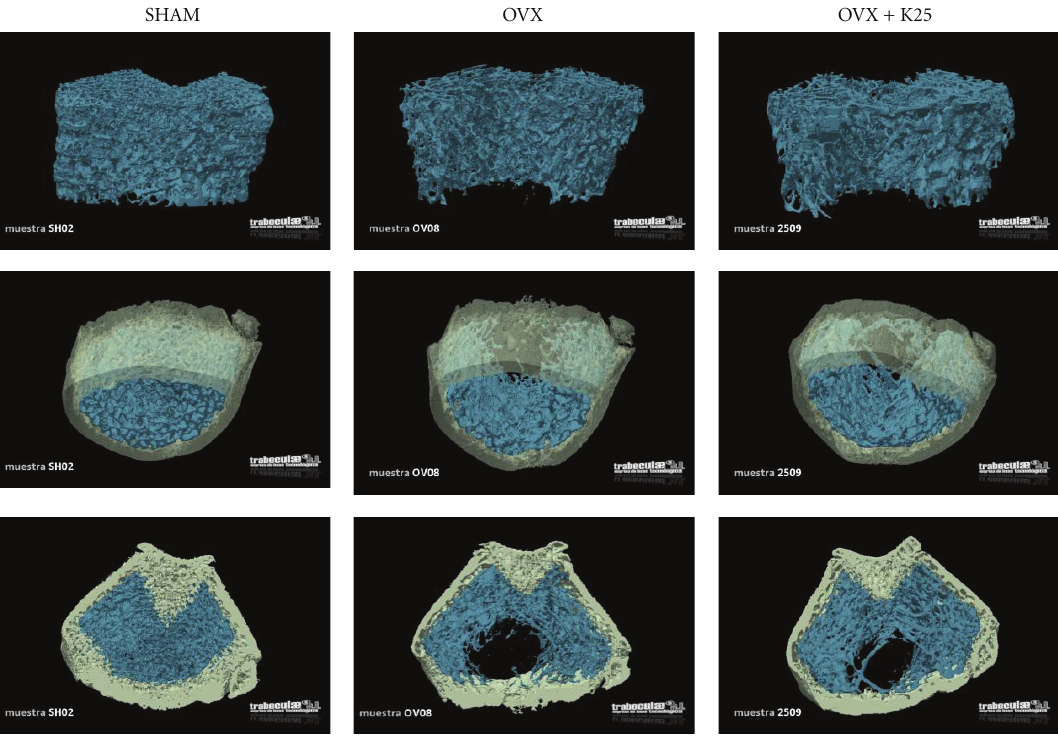
Figure 1: Representative images of bone trabecular 3D-microarchitecture in femur sections of all the study groups obtained by computed microtomography. The study groups of female Wistar rats, 6 months old at the beginning of the study, are ovariectomized (OVX) or sham- operated (SHAM) and randomized in the following groups: SHAM group (SHAM) treated with vehicle for 3 months; ovariectomized group (OVX) also treated with vehicle for 3 months; ovariectomized group treated with Kalsis at a dose of 25 mg/kg/day, for 3 months (OVX +